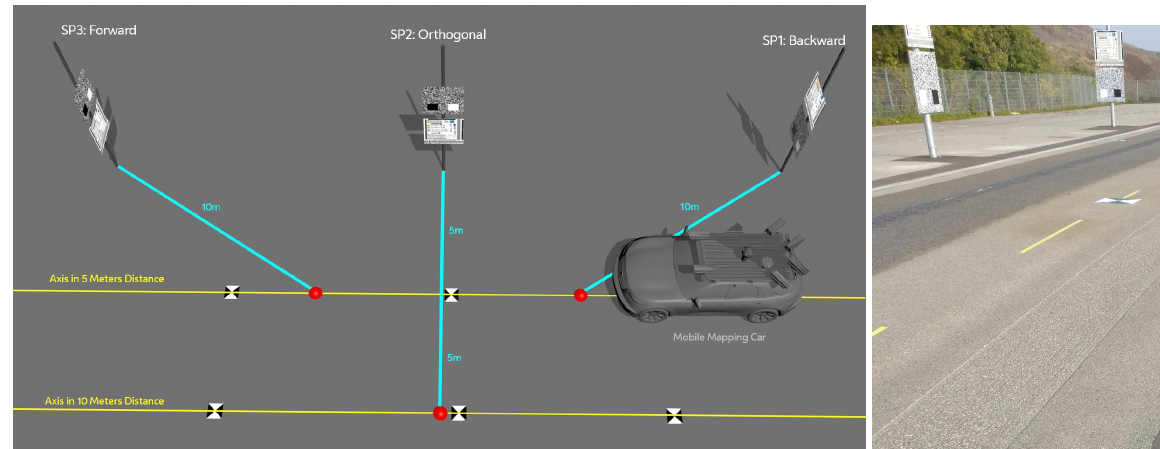
Figure 3. Test configuration with test charts, control points (checkerboards), driving axes in 5m and 10 m distance from the charts in orthogonal and forward and backward view, respectively. A section of the realized test configuration is shown on the